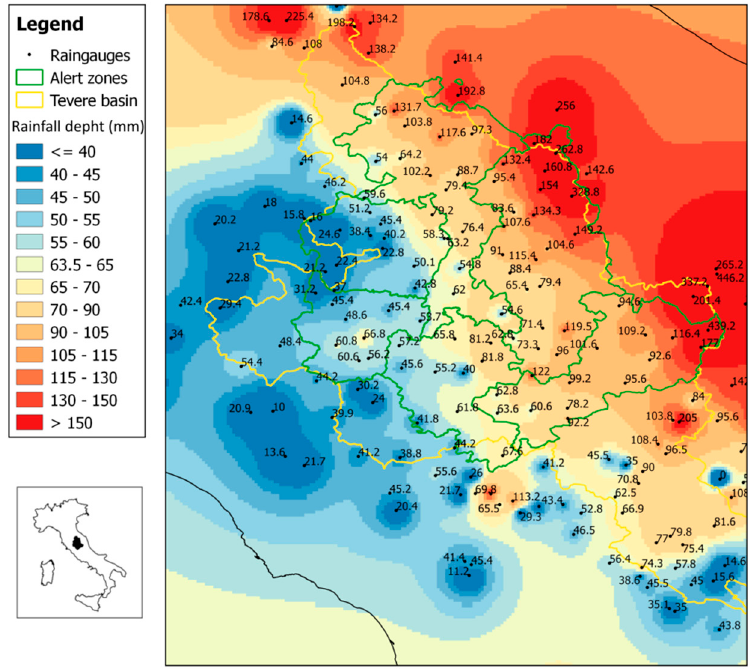
Figure 2. Localization of the rainfall event in the Umbria region, Italy ( left panel ); cumulated rainfall depth registered during the event occurred on November 2013 ( right panel ).